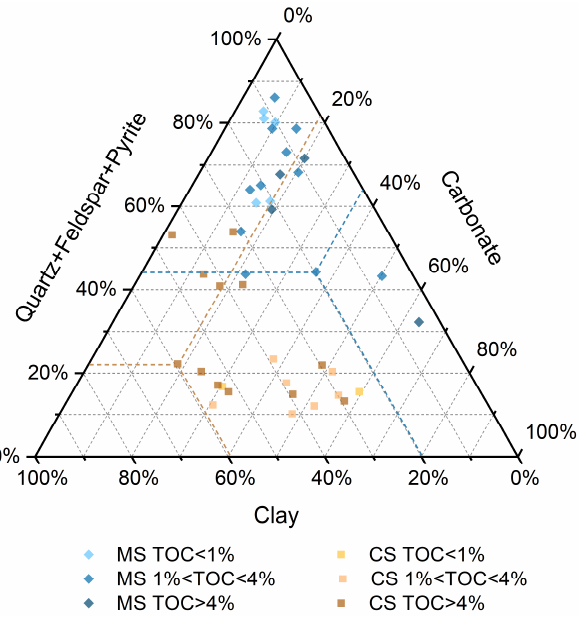
Figure 2. Mineral composition and TOC content distribution of marine shale (MS) and continental shale (CS).